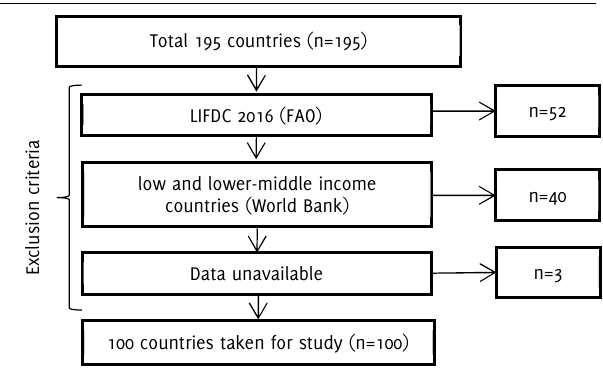
Figure 1 . Methods: 1A . Inclusion-Exclusion Criteria Used for Selection of the